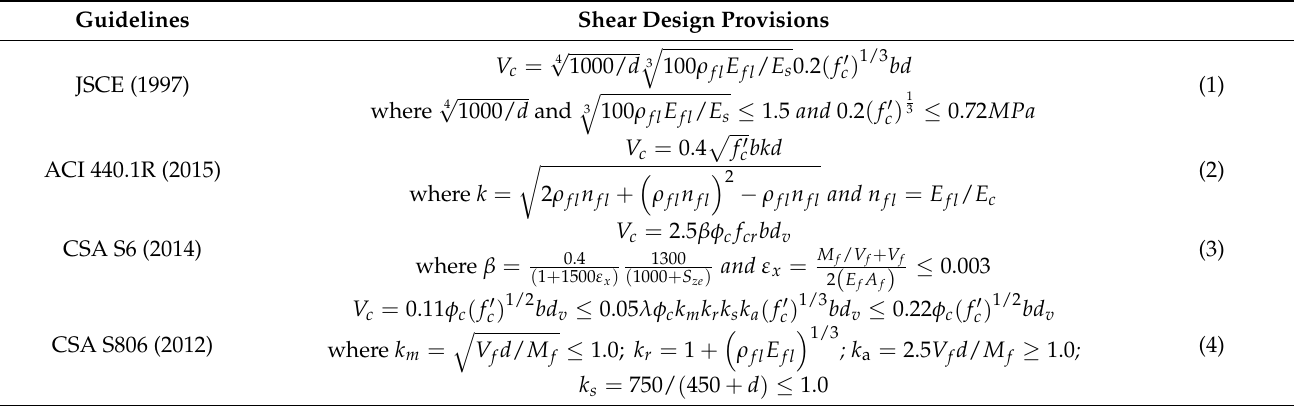
Table 1. Shear provisions of concrete